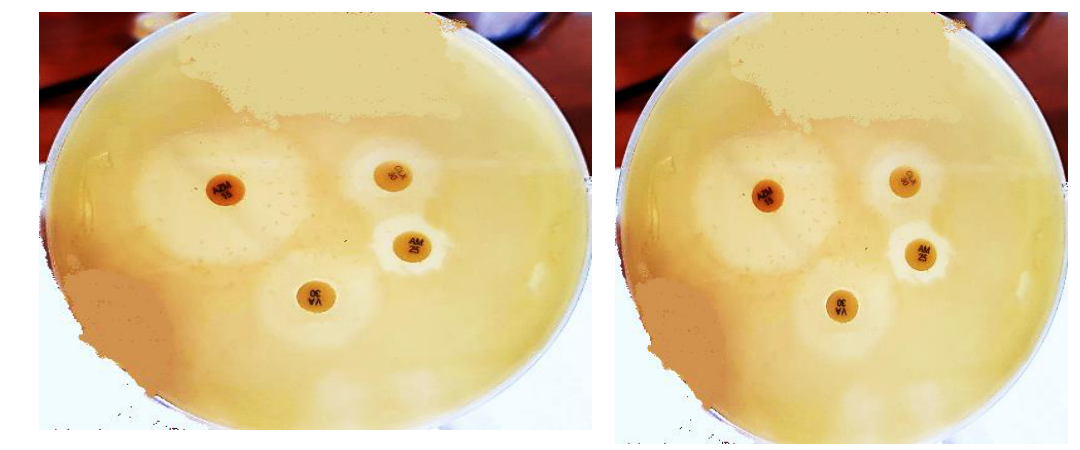
Figure 3. Antibiotics susceptibility profile of isolates. Antibiotics used in this procedure were: ampicillin (AM 10 µg), cephalexin (CLX, 30 µg), azithromycin(AZM, 15 µg) and vancomycin (VA 30